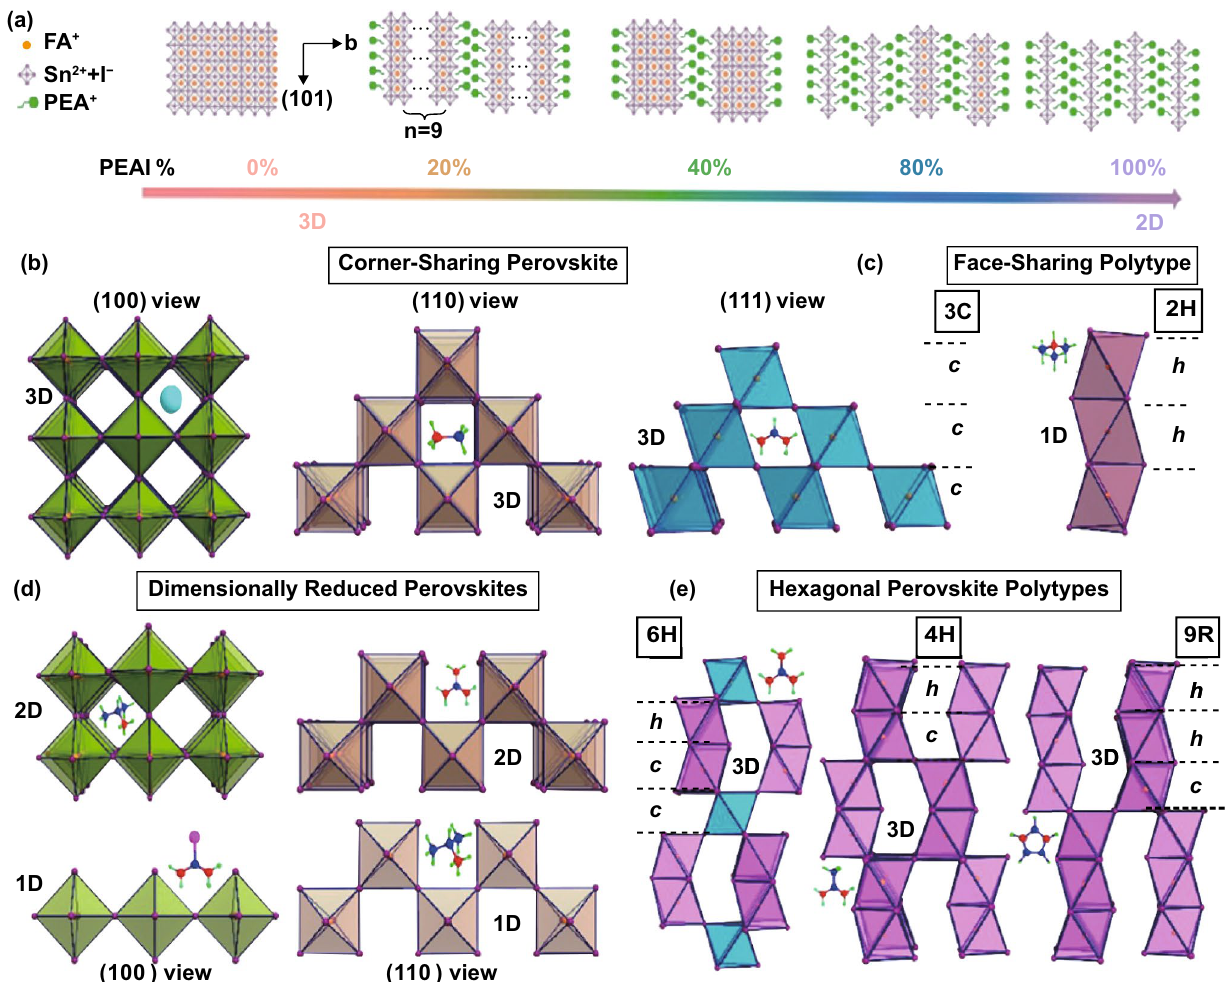
Fig. 7 a Schematic structures of mixed FA/PEA Sn perovskites with PEAI/FAI doping ratios of 0, 20, 40, 60, 80, and 100%. Reproduced with permission from Ref. [127]. b Three alternative views of the archetypal 3D perovskite structure viewed along the (100), (110), and (111) cleav- age planes. c “Perovskitoid” face-sharing building block of the 1D structures obtained for t > 1 representing the archetypal hexagonal polytype. d Perovskite structures obtained through dimensional reduction featuring corner-sharing 2D sheets and 1D chains through the (100) and (110) cleavage planes, respectively. e Hexagonal perovskite polytypes obtained from a linear combination of the corner-sharing 3D perovskite along the (111) cleavage plane and the 1D face-sharing polytype. The “h” and “c” symbols indicate hexagonal and cubic layers, respectively, and serve in identifying the layer sequence that characterizes the polytype. Reproduced with permission from Ref.